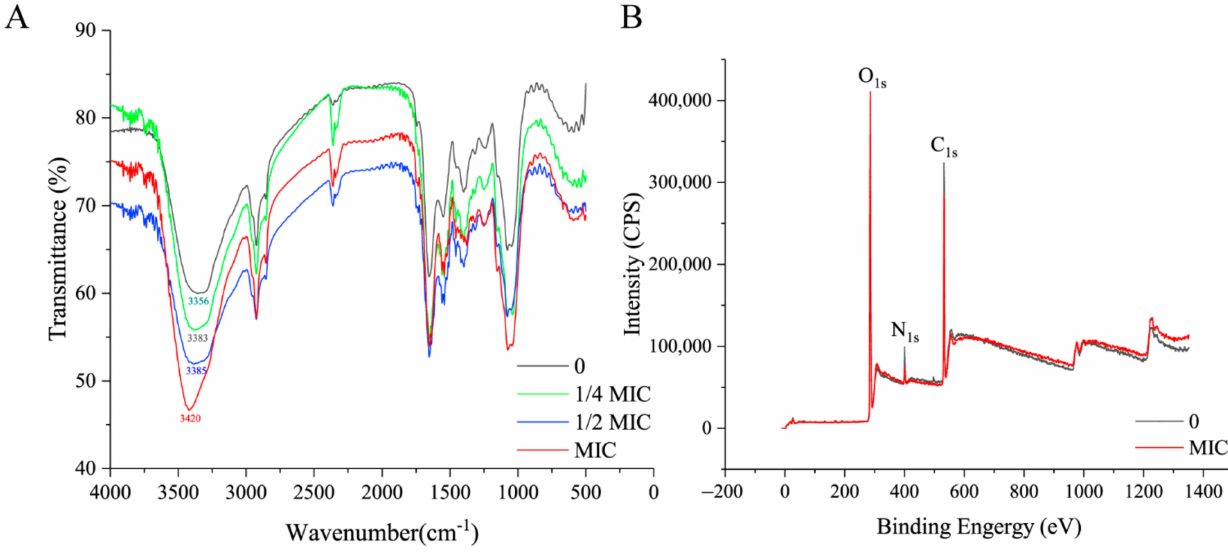
Figure 2. Influence of paeonol on the cell walls of A. flavus . ( A ) FT-IR spectra of mycelia treated with paeonol at 0, 1/4 MIC, 1/2 MIC, and MIC. ( B ) XPS survey spectra of mycelia treated with paeonol at 0 and